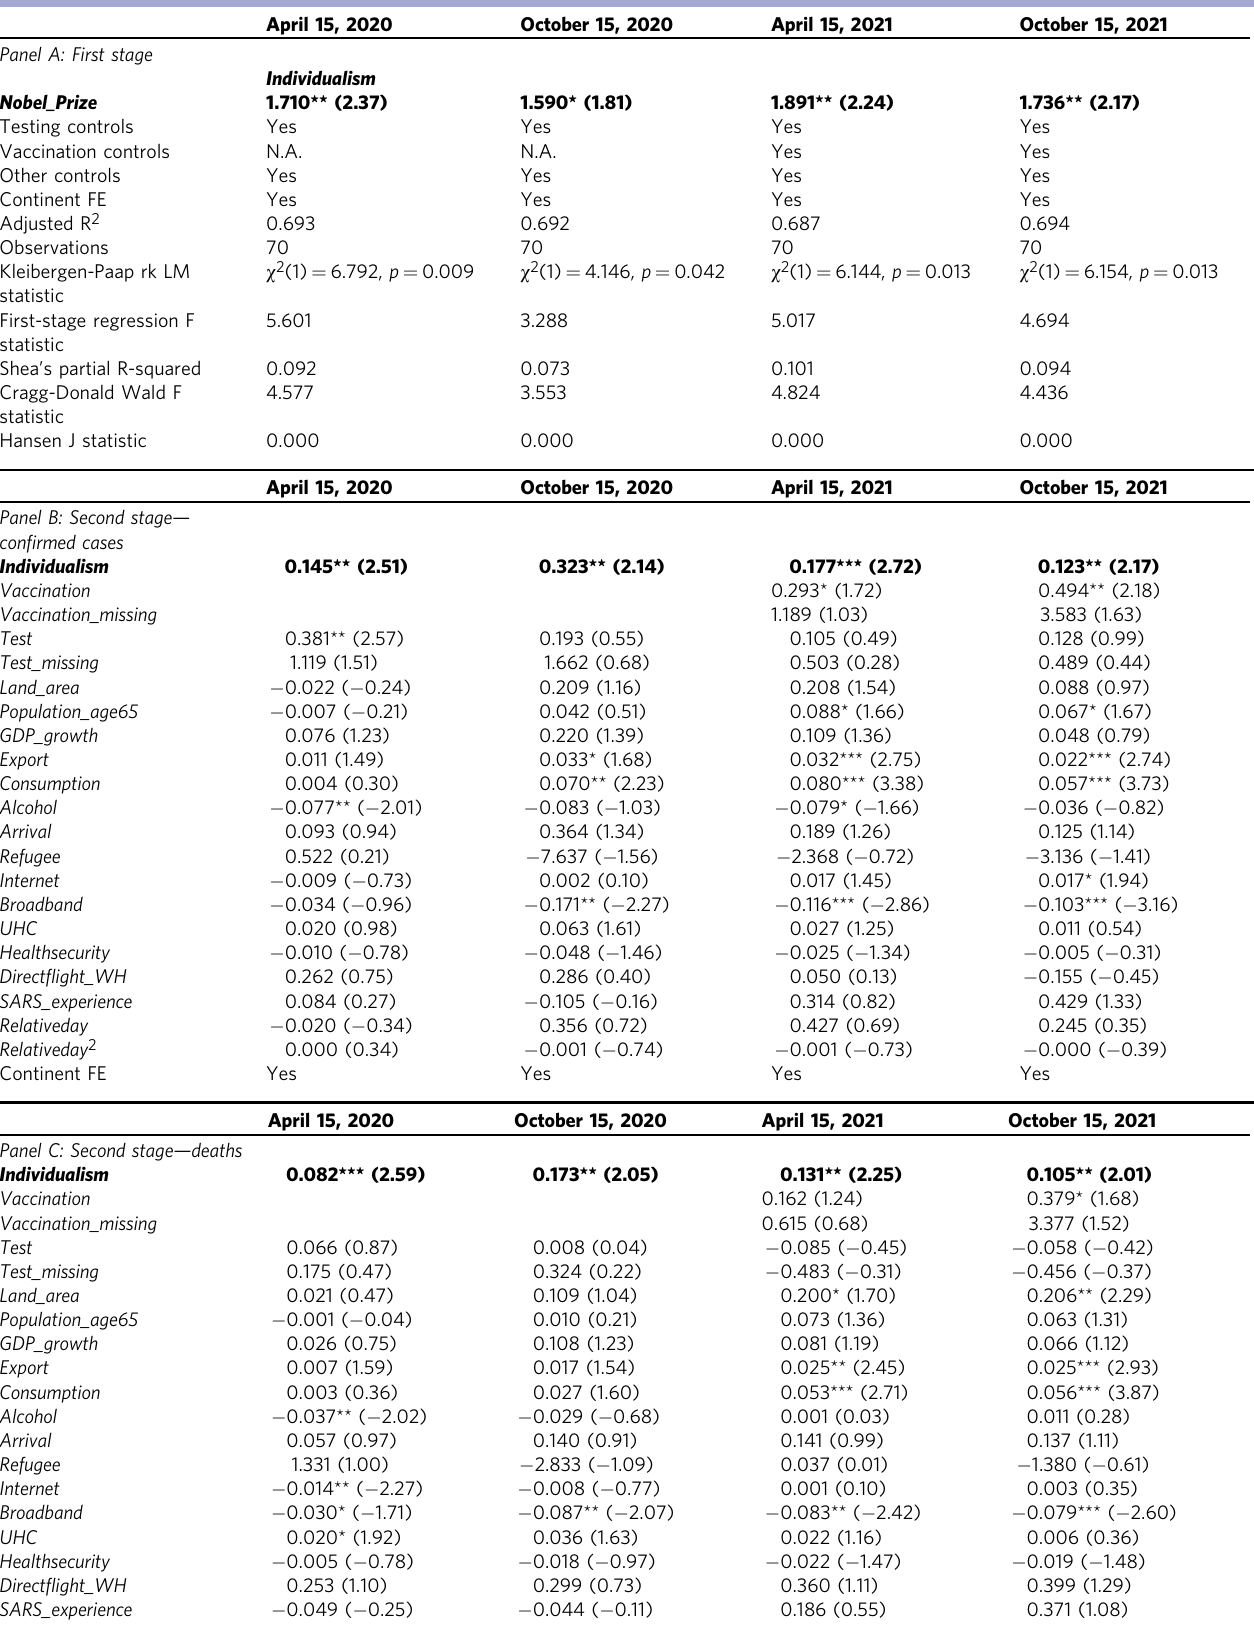
Table 1 Association between COVID-19 con fi rmed cases/deaths/death ratio and individualism using the number of nobel-prize winners as an instrument in an international